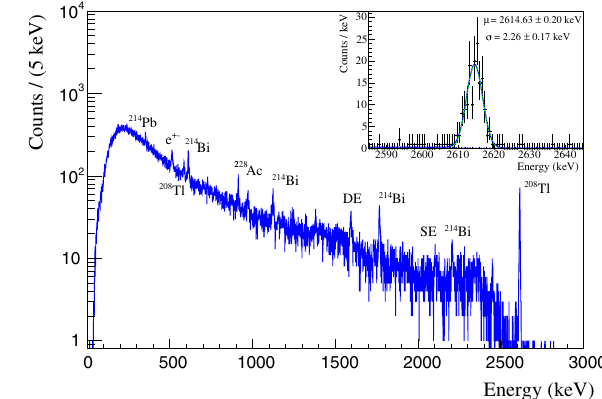
Fig. 13 Summedcalibrationspectrumfor19/20Li 2 MoO 4 bolometers. All the major peaks have been labeled. The inset shows a fit of the 208 Tl γ peak at 2614.5